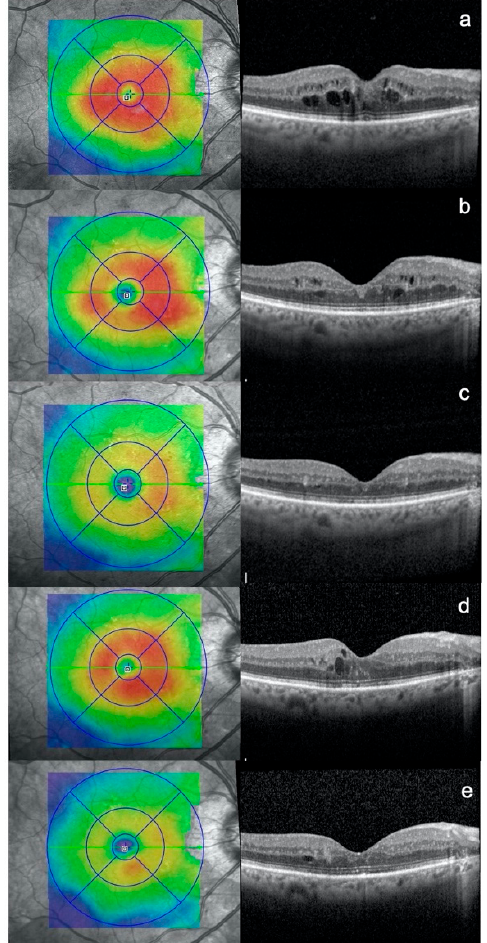
Figure 1. Optical coherence tomography (OCT) scans of a patient affected by diabetic macular edema: at ( a ) baseline, ( b ) 3 months after subthreshold micropulse macular laser (SMPL) 1st treat- ment, ( c ) 3 months after SMPL 2nd treatment, ( d ) additional 3 months after SMPL 2nd treatment, ( e ) 3 months after SMPL 3rd